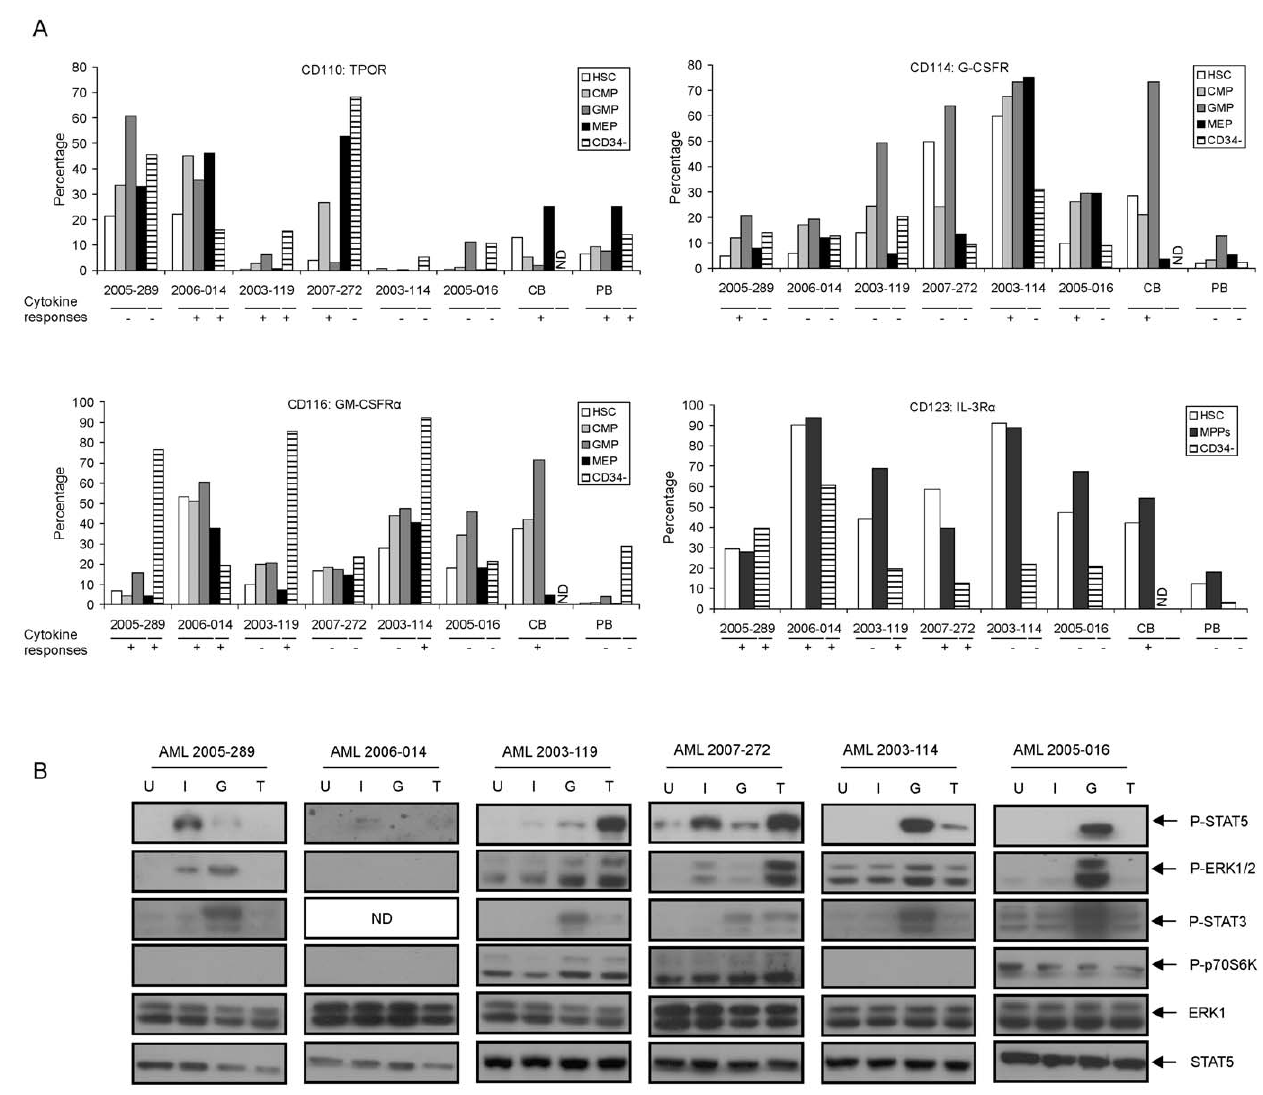
Figure 3. Cytokine and growth factor receptor expression in normal and leukemic cells. The expression of receptors for TPO (CD110), GM- CSF (CD116), IL-3 (CD123) and G-CSF (CD114) was analyzed by FACS. (A) MNCs from AML samples and CD34 + cells CB and PB were stained with antibodies against receptors, together with CD34, CD38, CD45RA and CD123 for 30 minutes. CD123 expression was analyzed in HSCs, MPPs (CD34 + CD38 + ) and CD34 2 populations. For CB cells, no CD34 2 fraction was available. The cytokine responses for STAT5 activation in CD34 + versus CD34 2 populations are also indicated (‘‘ + ’’ indicates that STAT5 was activated by the respective cytokine; ‘‘ 2 ’’ indicates that STAT5 was not activated). (B) 1 6 10 6 /ml CD34 + cells were sorted by MoFlo from AML MNCs and suspended in HPGM for 2 hours. Cells were harvested after stimulation with 1.0 ng/ml IL-3 (I), 100 ng/ml G-CSF (G) or 100 ng/ml TPO (T) for 15 minutes or left unstimulated (indicated as U) for Western bloting. ND, not